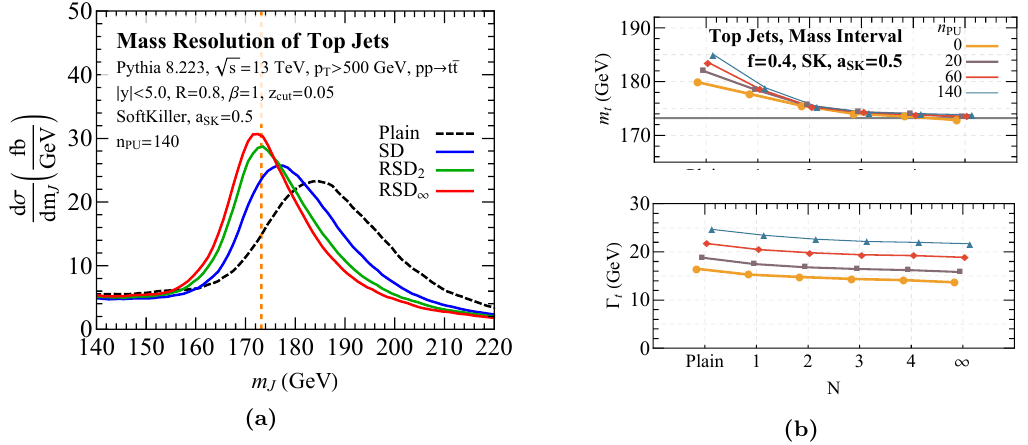
Figure 11. (a) Same as (cid:12)gure 7a, but with 140 pileup vertices and using a SoftKiller parameter of a SK = 0 : 5. (b) Central mass values and widths as a function of N for several pileup multiplicities, using the benchmark RSD/SoftKiller parameters and f = 0 :